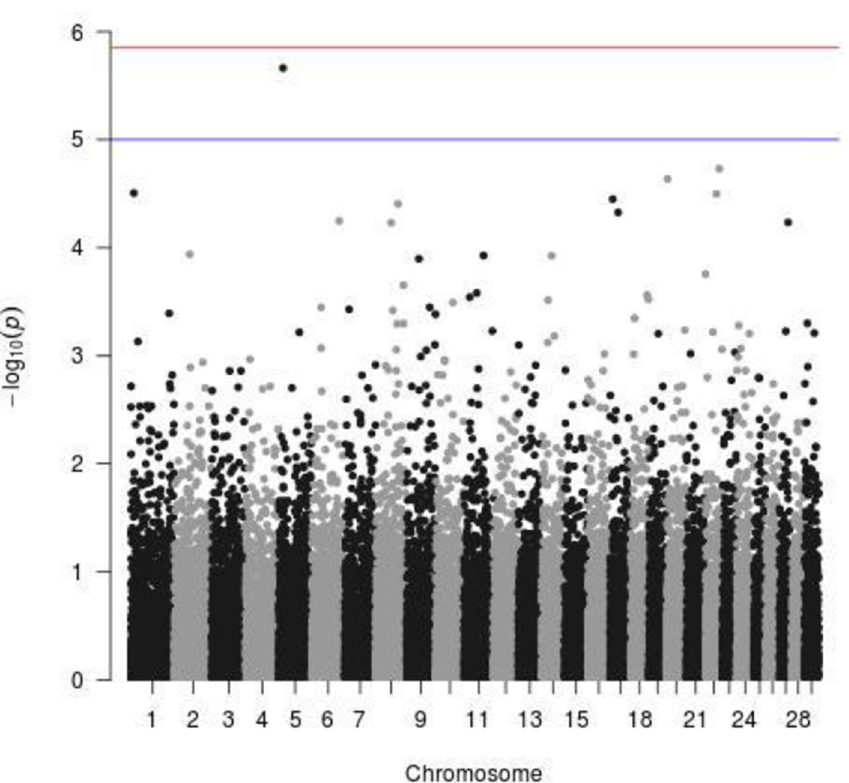
Fig 4. Significant SNPs related to tolerance against trypanosomiasis in crossbred cattle (blue line = indicative threshold–log10(p) = 5; red line = Bonferroni threshold–log10(p) = 5.86).